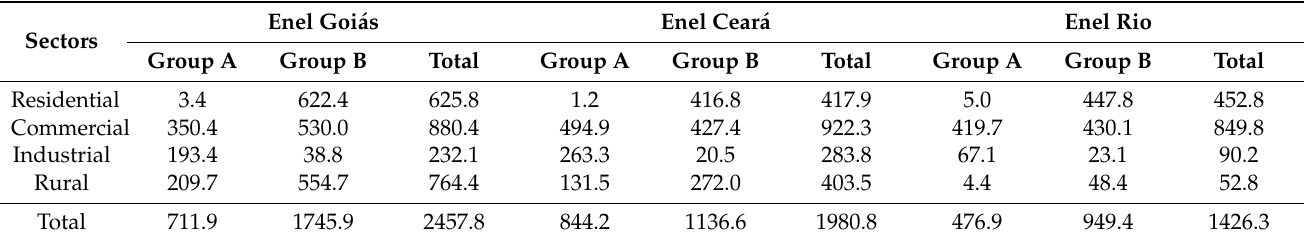
Table 5. Potential market for MMDG for each distributor, in GWh.